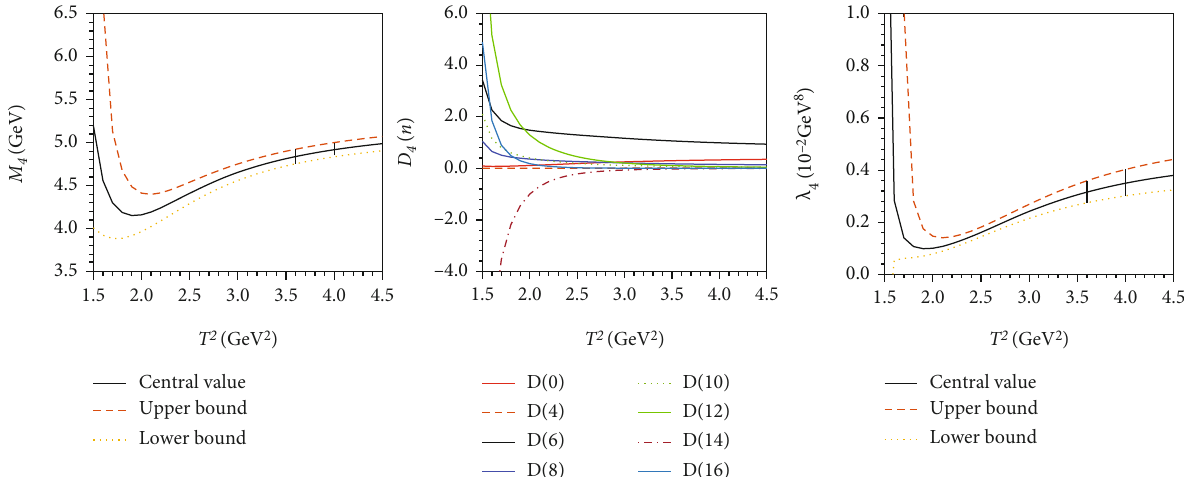
Figure 3: The numerical results of J curve is from the lower values; D and dotted curve is from the lower